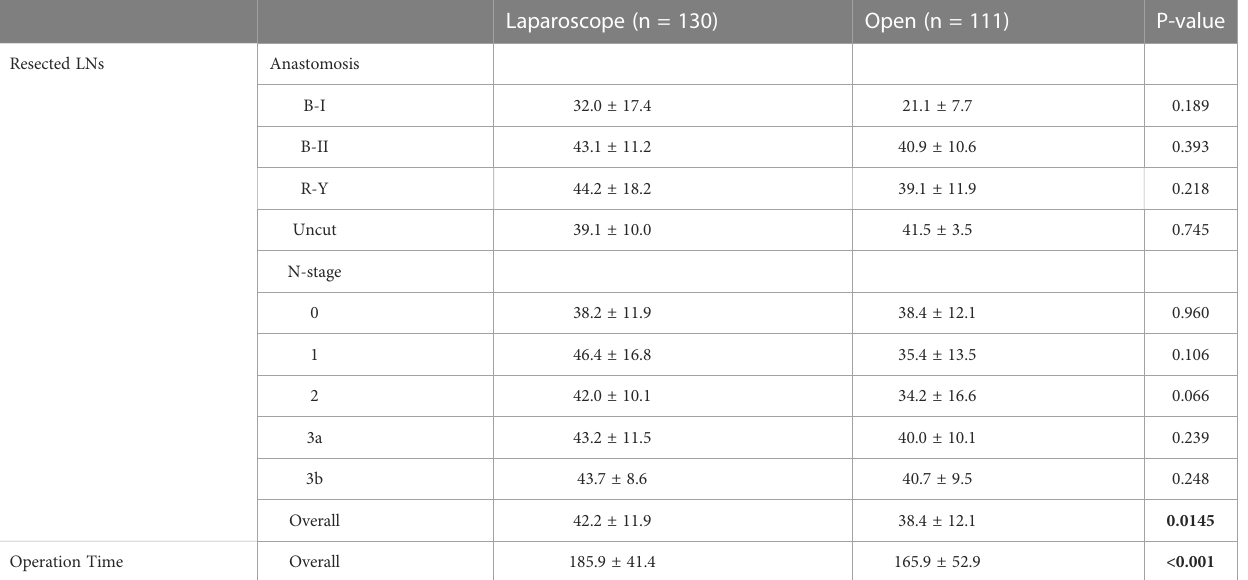
Bold values indicate that the data is statistically signi fi